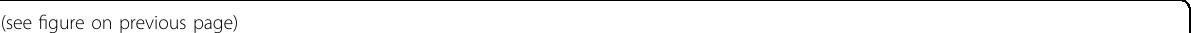
Fig. 5 Ahi1 de fi ciency increased nuclear GR level and reduced the response to antidepressant treatment in Ahi1 KO mice. A Cytoplasmic and nuclear GR in the hypothalamus of Ahi1 − / − and Ahi1 + / − mice was examined by Western blotting. Cytoplasmic protein β -actin and nuclear protein histon-3 served as controls. B The protein level of GR was expressed as fold changes relative to β -actin (** P = 0.002) or histone-3 (*** P < 0.0001) versus control (Ahi1 + / − mice. C Immuno fl uorescent staining of the hypothalamic sections from control (Ahi1 + / − ) mice and Ahi1 KO (Ahi1 − / − ) mice. GR (green) and the nuclei (blue) were seen in the merged images. Scale bar: 20 μ m. D Homozygous ( − / − ) and heterozygous ( + / − ) Ahi1 KO mice received spatial restraint stress treatment 2 h daily for 4 weeks. From the second week, mice were treated (i.p.) with imipramine (IM) or normal saline (NS) daily for 3 weeks. Behavioral tests TST and FST were performed. (TST: F (1,55) = 4.070, *** P < 0.0001 versus saline-treated Ahi1 + / − + NS mice group; FST: F (1,55) = 1.707, ** P = 0.0093 versus saline-treated Ahi1 + / − + NS mice group). ( n = 14 – 15 mice per group). E The proposed diagram of the modulation of Ahi1 protein on stress-mediated GR signaling. In normal conditions, glucocorticoid (GC) binds to its receptor GR and enters the nucleus. Ahi1 binds GR to prevent its nuclear translocation (left). Under chronic stressful conditions, high HAP axis activity releases glucocorticoid (GC) that binds to GR to lead to its nuclear translocation and regulation of depression-related gene expression. The nuclear translocation of GR reduces Ahi1 stability (middle). When Ahi1 is absent or de fi cient, more GR is translocated to the nucleus, and this increased basal stress response reduces response to antidepressants